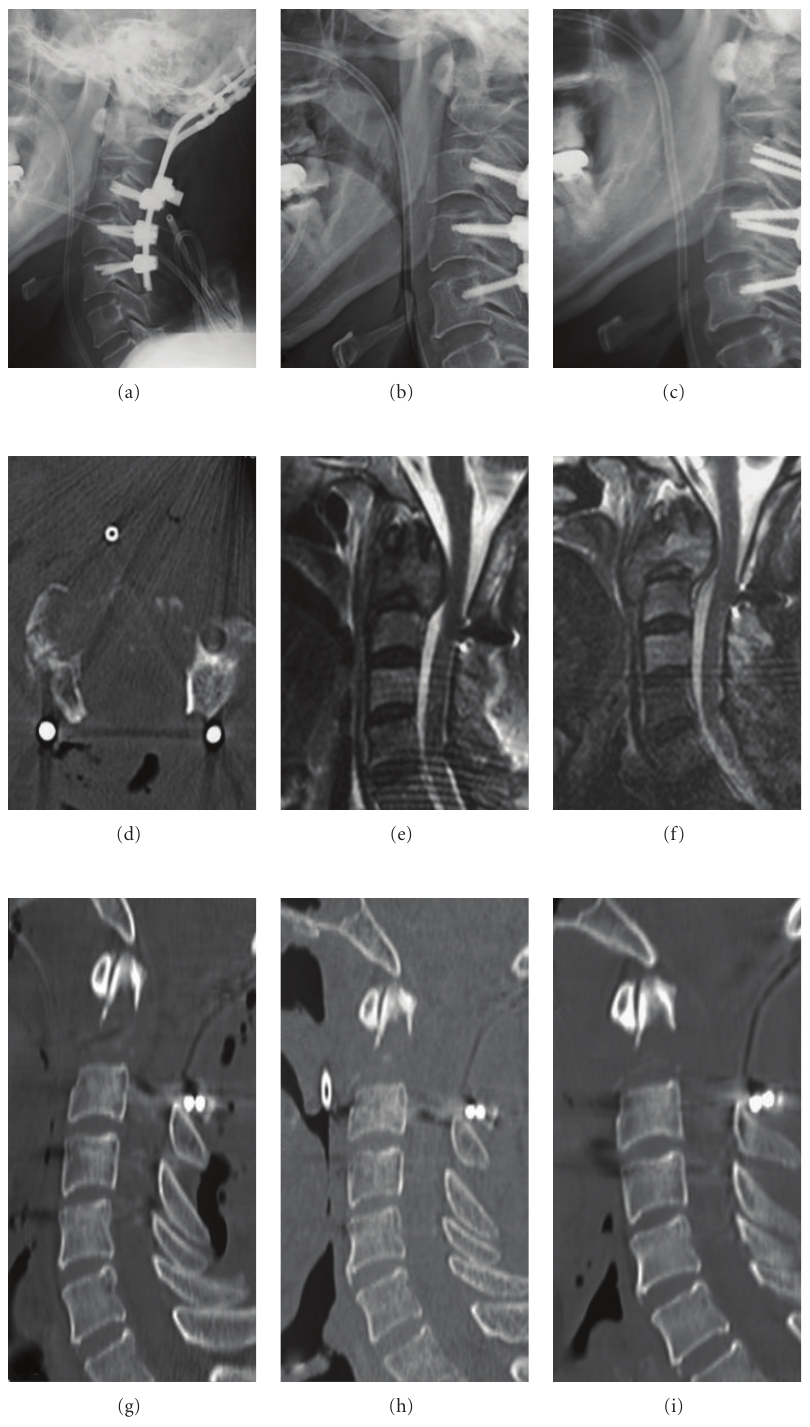
Figure 2: (Images of left column (a, d, g), middle column (b, e, h), and right column (c, f, i) are postoperatively 1 week, 4 weeks, and 9 weeks, resp.) Lateral radiograph (a, b, c) and axial image of CT at the level of C2 (d) showing disappearance (a, c, d) or decrease (b) of the middle pharyngeal space surrounded by the thickened pharyngeal wall. Reconstructed sagittal CT 1 week postoperatively (g) showing the disappearance of the middle pharyngeal space, that 4 weeks postoperatively (h) shows improvement and that 9 weeks postoperatively (i) shows deterioration. T2-weighted sagittal MR imaging 9 weeks postoperatively (f) showing enlargement of the mass lesion at C2 compared to that at 4 weeks postoperatively